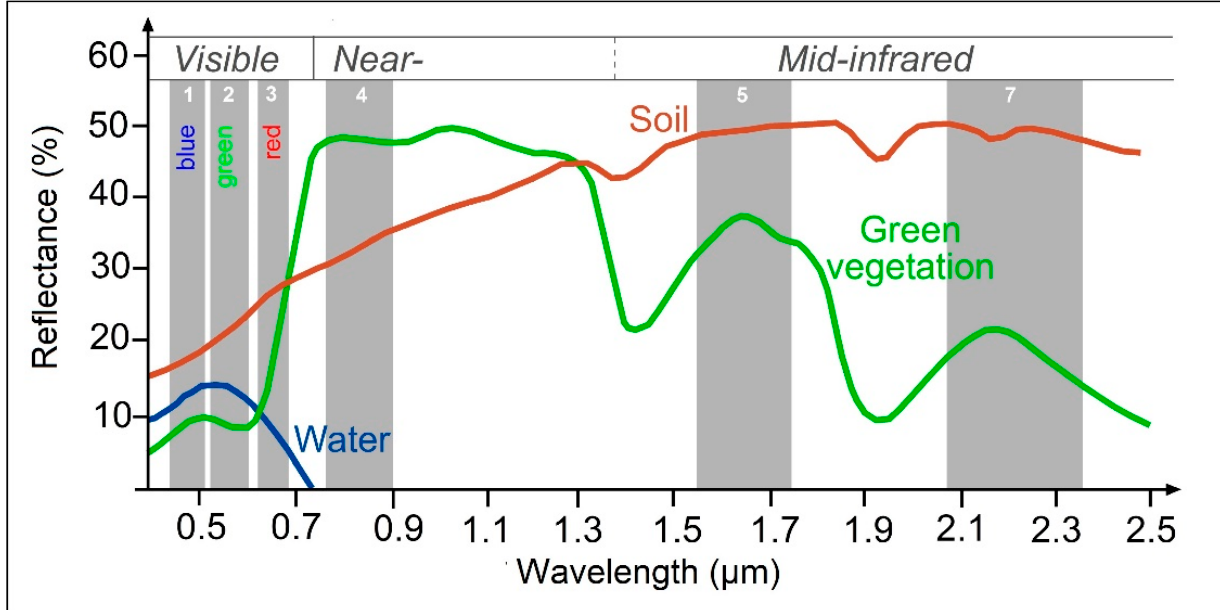
Figure 2. Example of spectral response patterns of water, soil, and green vegetation (https://seos- project.eu/classification/classification-c01-p05.html, accessed on 20 November 2022).